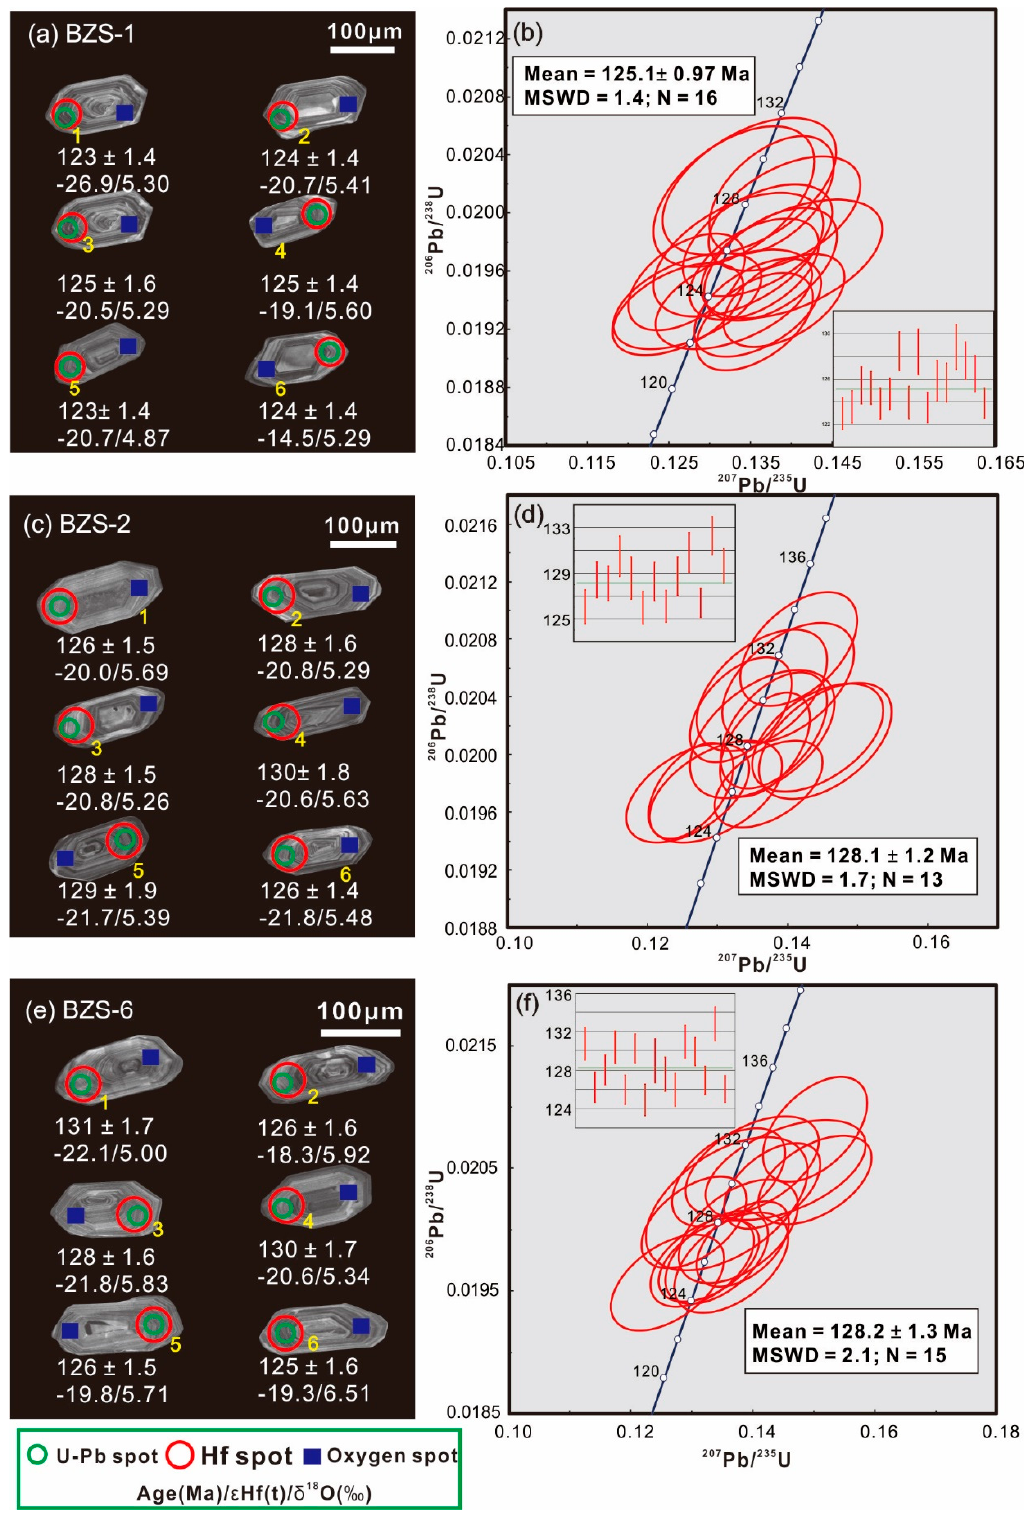
Figure 5. Cathodoluminescence images of representative analysed zircons with in situ U-Pb-Hf and O isotope data and zircon U-Pb concordia diagrams for Sample BZS-1 ( a , b ), Sample BZS-2 ( c , d ) and Sample BZS-6 ( e , f ) from the Banzhusi granite porphyry. Abbreviations: MSWD, weighted mean square.